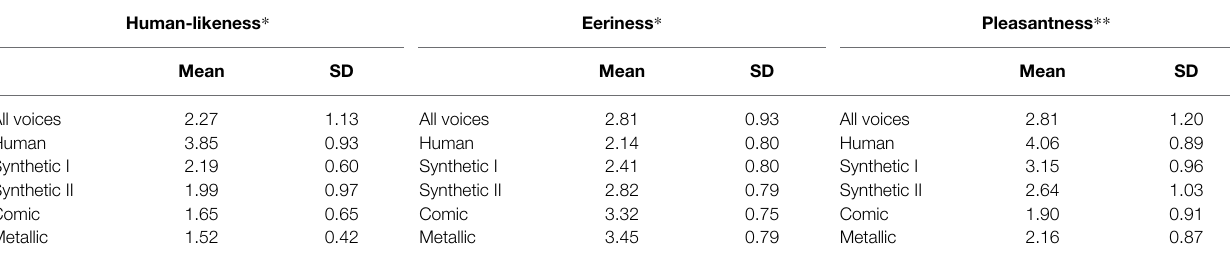
TABLE 2 | Means and standard deviations of the ratings of the five